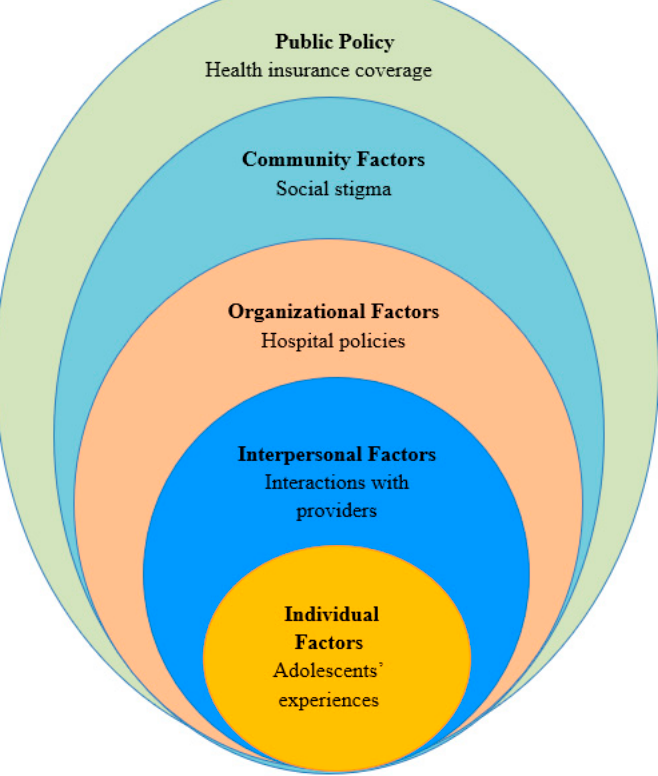
Figure 2. Factors influencing access to care for adolescents.